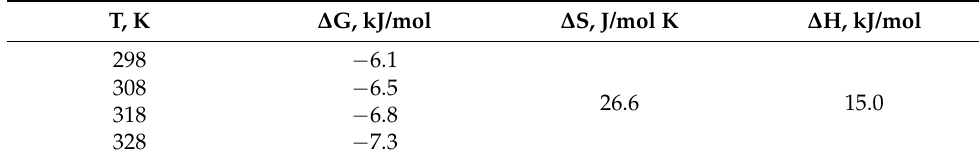
Table 4. The removal efficiency of Pb(II) by GA/MNPs in the presence of some interfering ions.